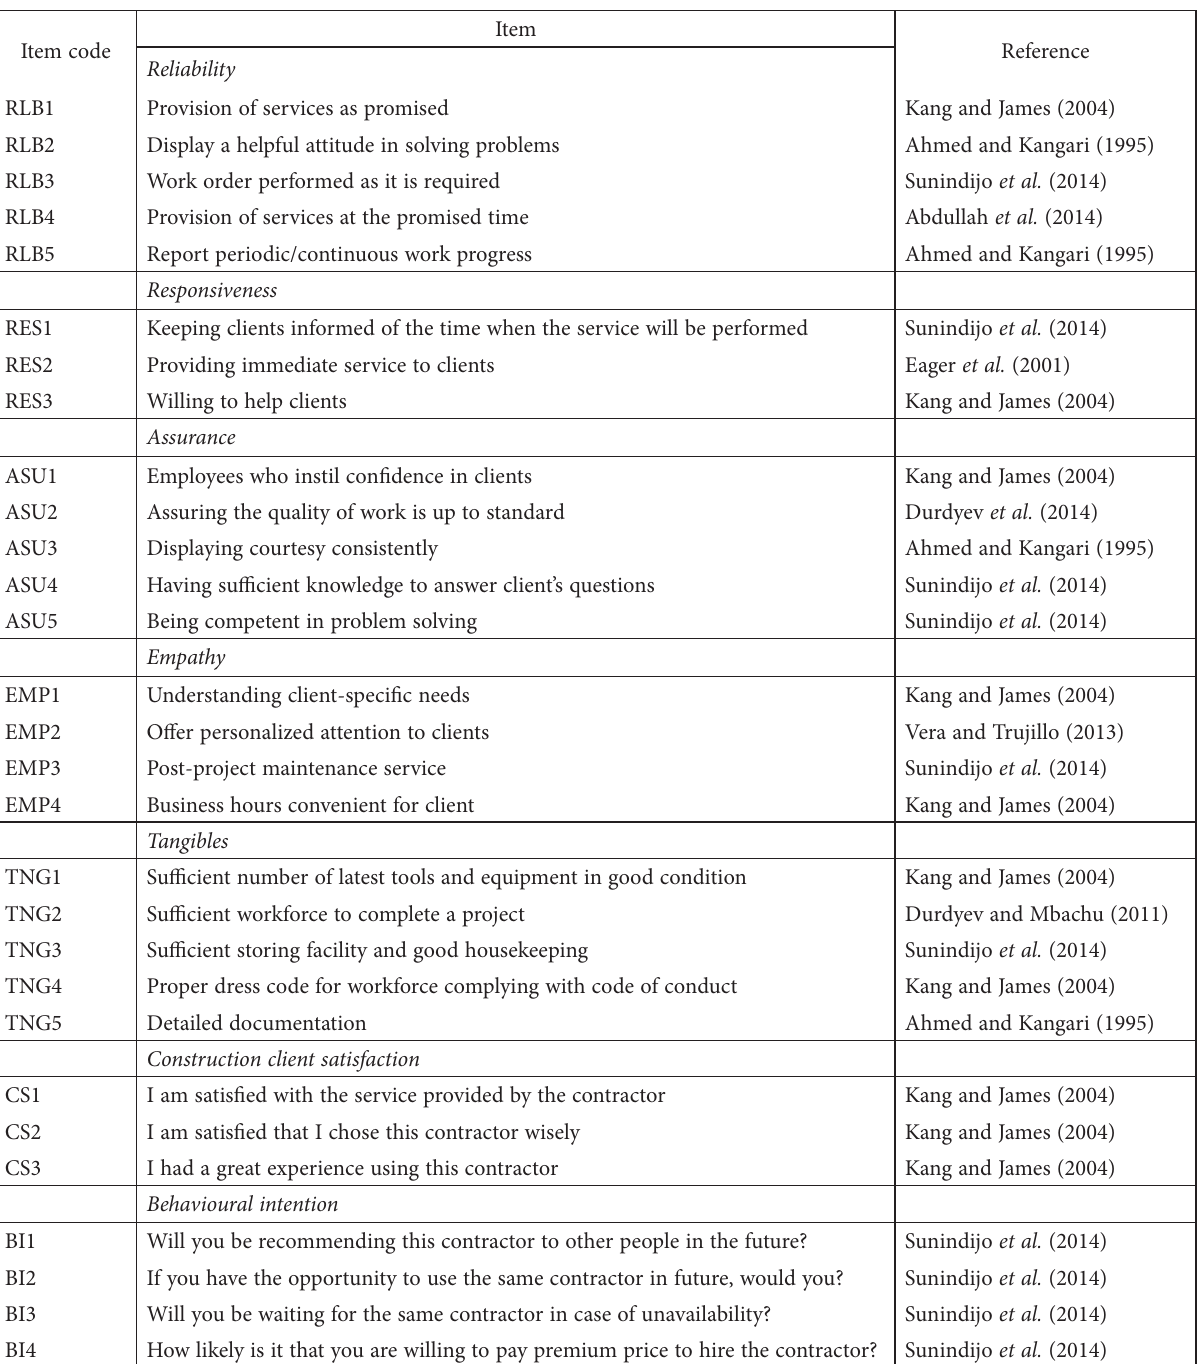
Table 1. Items used for questionnaire